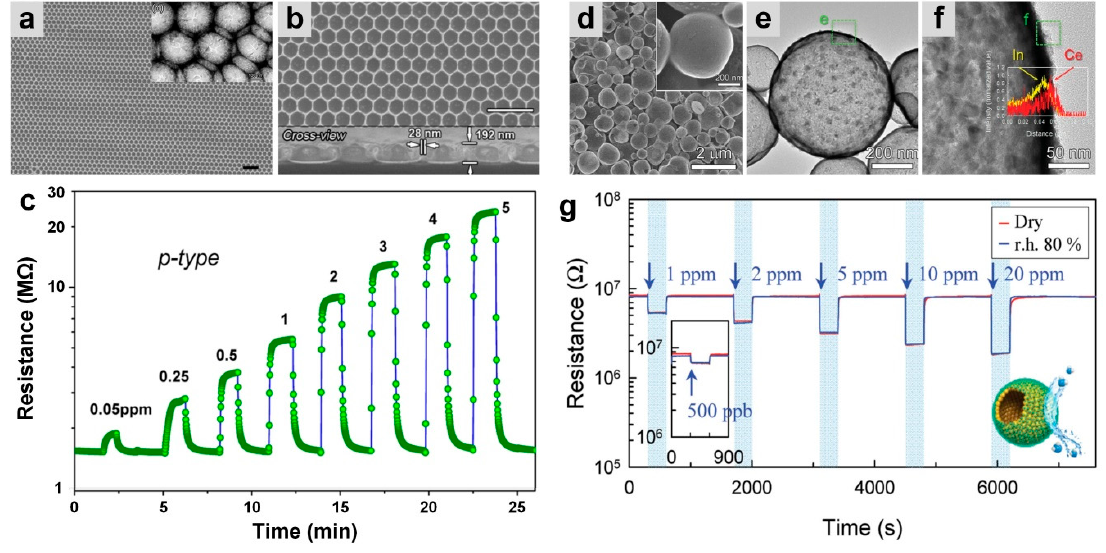
Figure 13. ( a ) Typical SEM image of the LaFeO 3 ordered porous film and the corresponding TEM image (inset). ( b ) High-magnification image of a, and the corresponding cross view (inset). ( c ) Dynamic sensing response of the fabricated device upon exposure to 0.05 to 5 ppm of ethanol [70]. ( d ) SEM and ( e ) TEM images of 11.7 Ce-In 2 O 3 hollow spheres with ( f ) elemental mapping. ( g ) Dynamic sensing transients of 11.7 Ce-In 2 O 3 hollow spheres exposed to 0.5 to 20 ppm of acetone at 450 ◦ C in dry (red) and r.h. 80% (blue) [74].